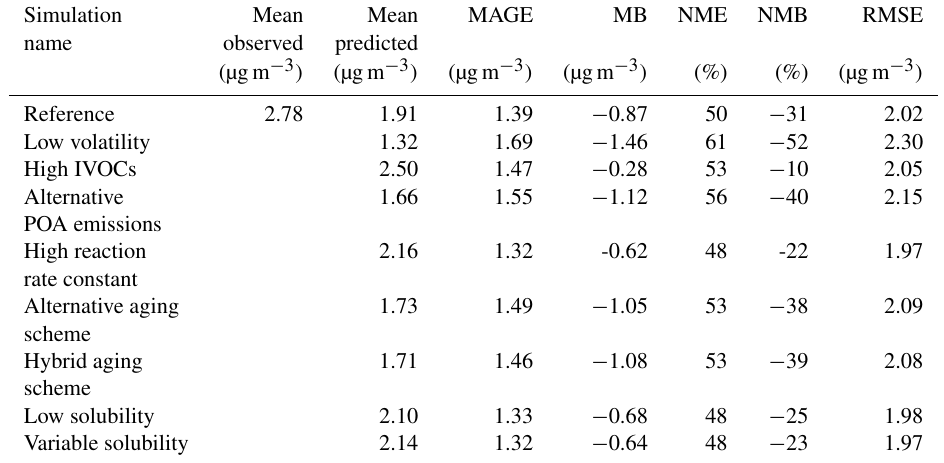
Table 3. Statistical evaluation of EMAC SOA against AMS OOA using 61 datasets in downwind urban and rural areas during